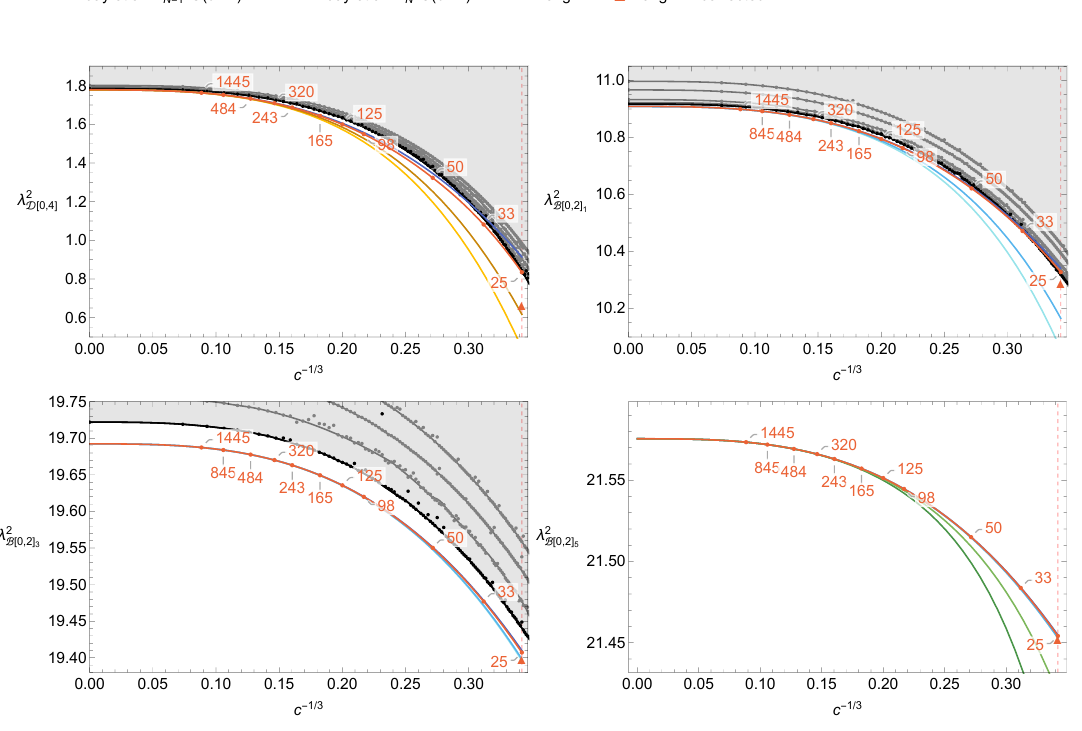
Figure 11. OPE coefficients of non-chiral algebra short multiplets with spin 0, 2, 4, 6, against c − 1 / 3 . The gray shaded regions are numerical upper bounds (available for spin 0, 2, 4) from [19]. The red numbers are central charges (a strict subset of the chosen values correspond to physical theories). Short inversions produce the same results as the supergravity ones. The red curves correspond to stabilized iterative long inversions up to spin 16 (see text for detailed explanation). For c = 25 , we also perform a corrected (triangular point) iterative long inversion using numerical data from [19]. We also show higher order c α corrections (denoted as O ( c α ) in the plot legend) from [13, 23] whenever